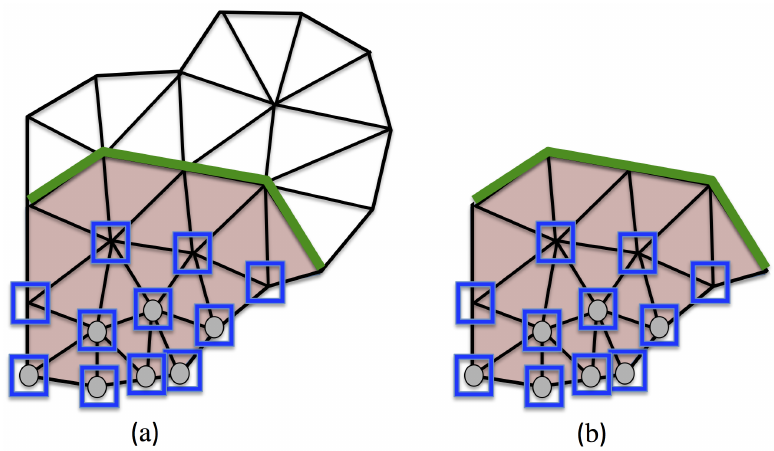
Figure 2. Schematic view of the reduced experimental domain, with linear triangular elements. In both figures, Ω R is red. On the left, there is the mesh of Ω . On the right, there is the reduced mesh (i.e., the mesh of Ω R only). In ( a ), the nodes having their degrees of freedom in are on the green line, I the nodes having their degrees of freedom in are in blue squares, and the grey nodes have their F (cid:63) , degrees of freedom in . In ( b ), the green line, the blue squares and the grey nodes are related to R I (cid:63) and (cid:63) , F R